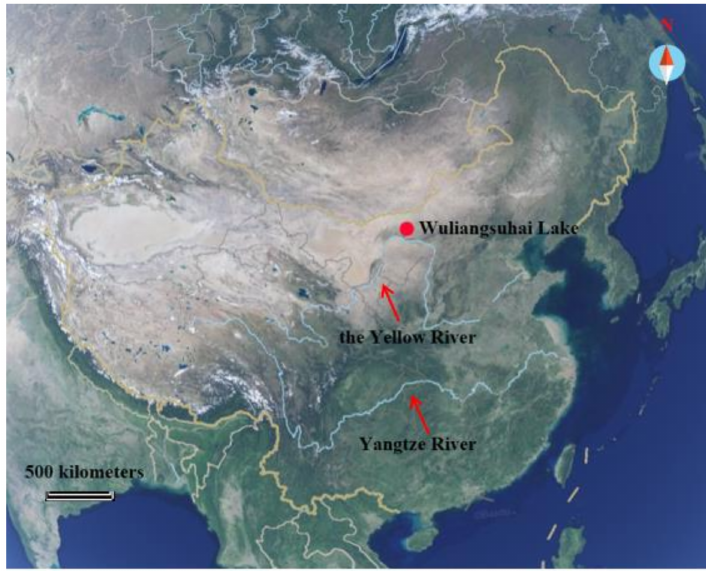
Figure 1. Location map of study